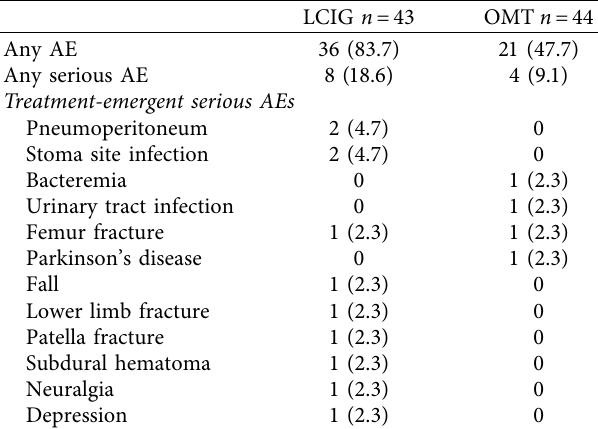
Table 3: Summary of serious AEs in the safety